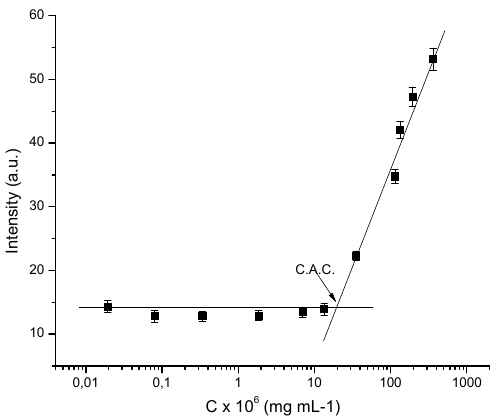
Figure 2. Plot of the intensity of scattered light as a function of the G4-F dendrimer concentration.